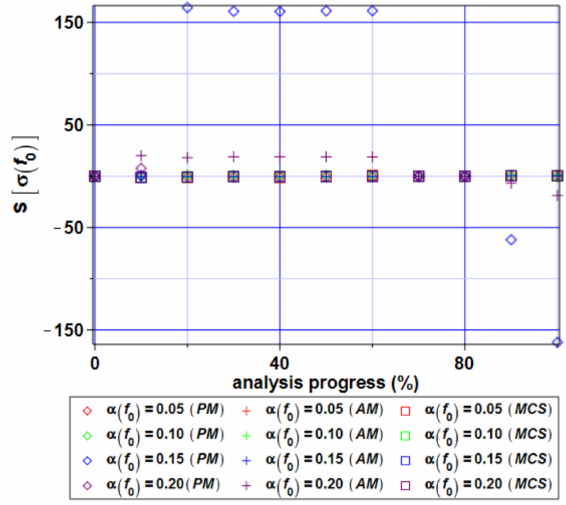
Figure 25. Skewness of the extreme von Mises stress S[ σ (f 0 )] for the beam.